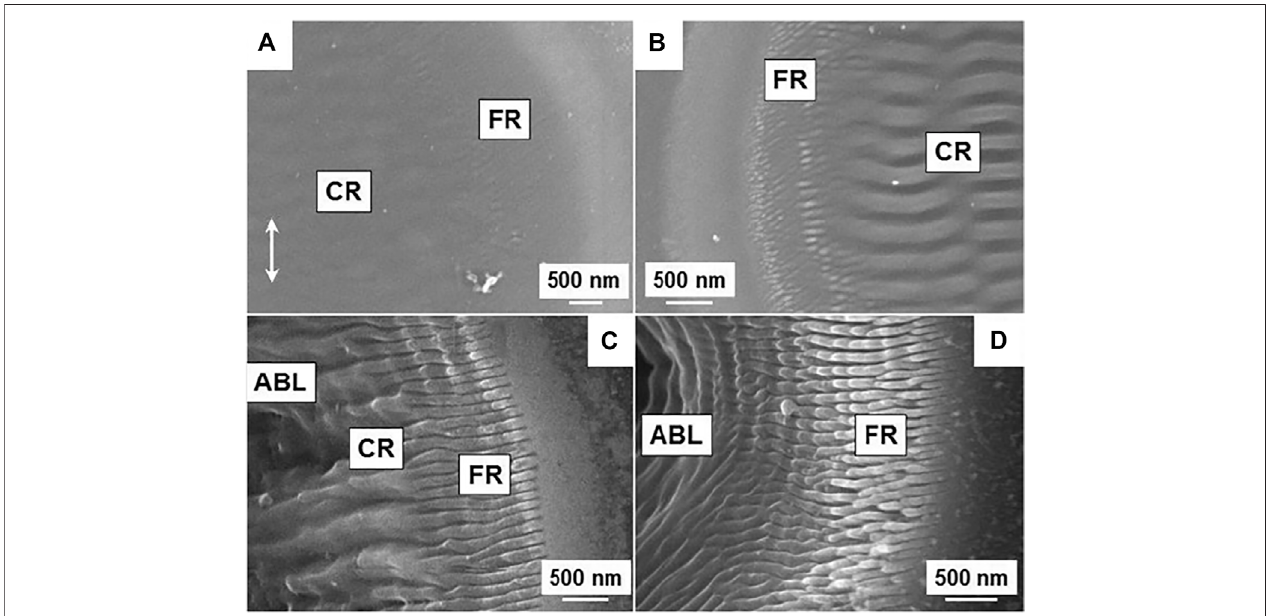
FIGURE4| SEMimagesofablationcrateredge(ABL), fi ne(FR)andcoarse(CR)ripplesformedwithinthecratersondiamondsurfacefordifferentnumberofpulses: 10 (A) , 30 (B) , 100 (C) , and 300 (D) [41].